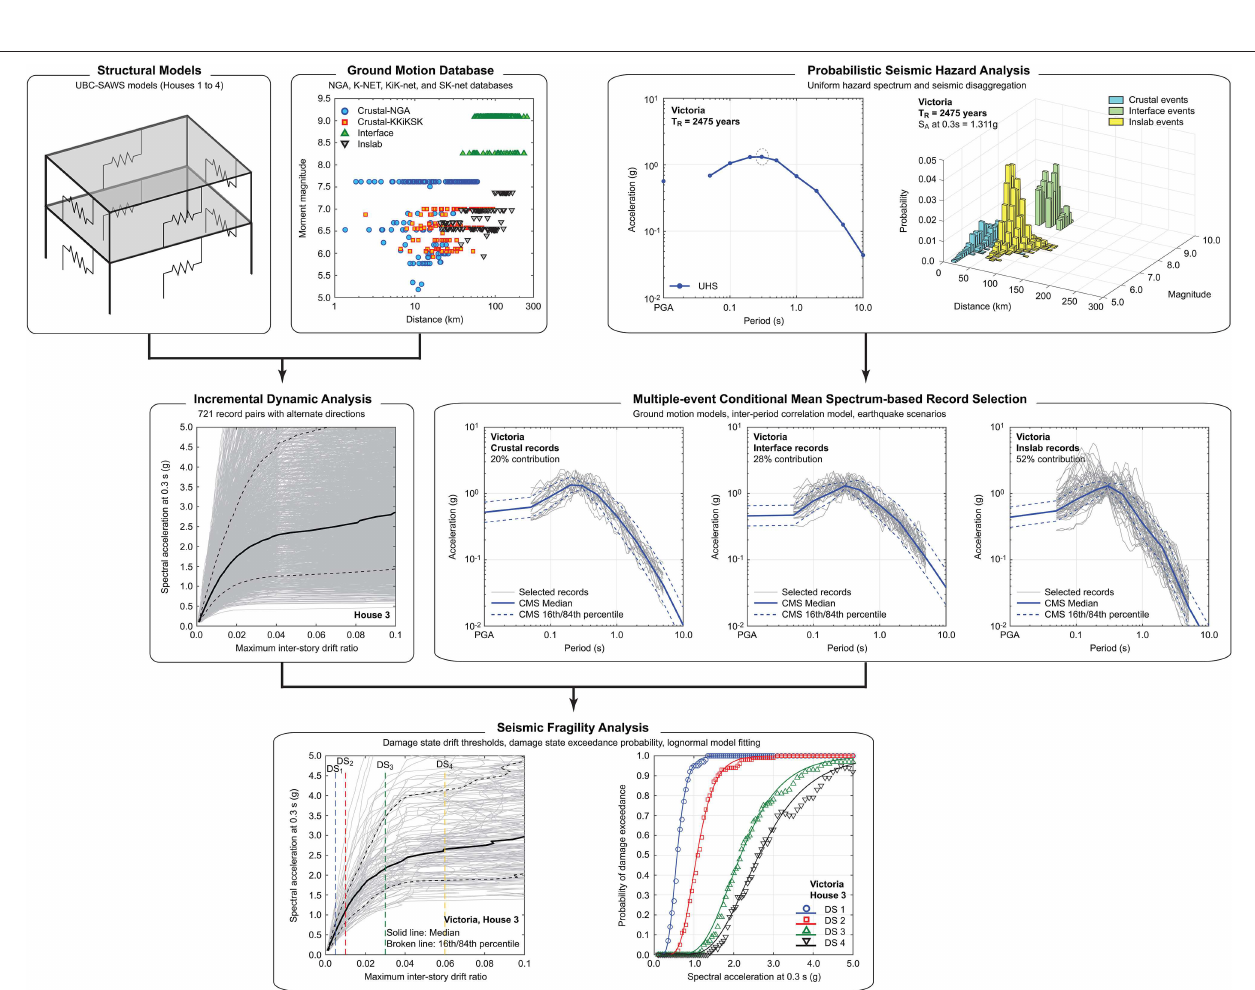
FIGURE 6 | Seismic fragility analysis procedure.